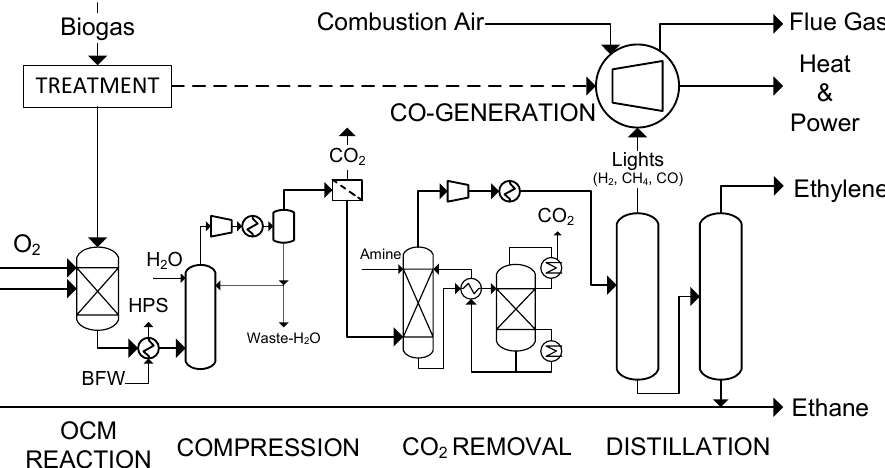
Figure 1. Process flow diagram of the Bio-OCM process. Dashed lines represent optional streams and units. Reproduced with permission from Penteado, Ph.D. Thesis, TUB, 2021